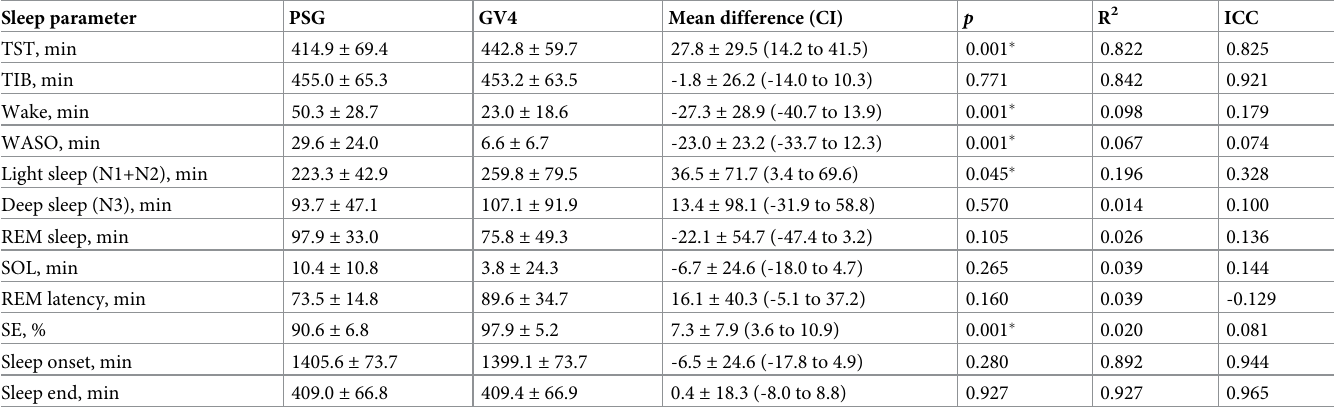
Table 3. Single comparisons of sleep parameters between PSG and GV4.